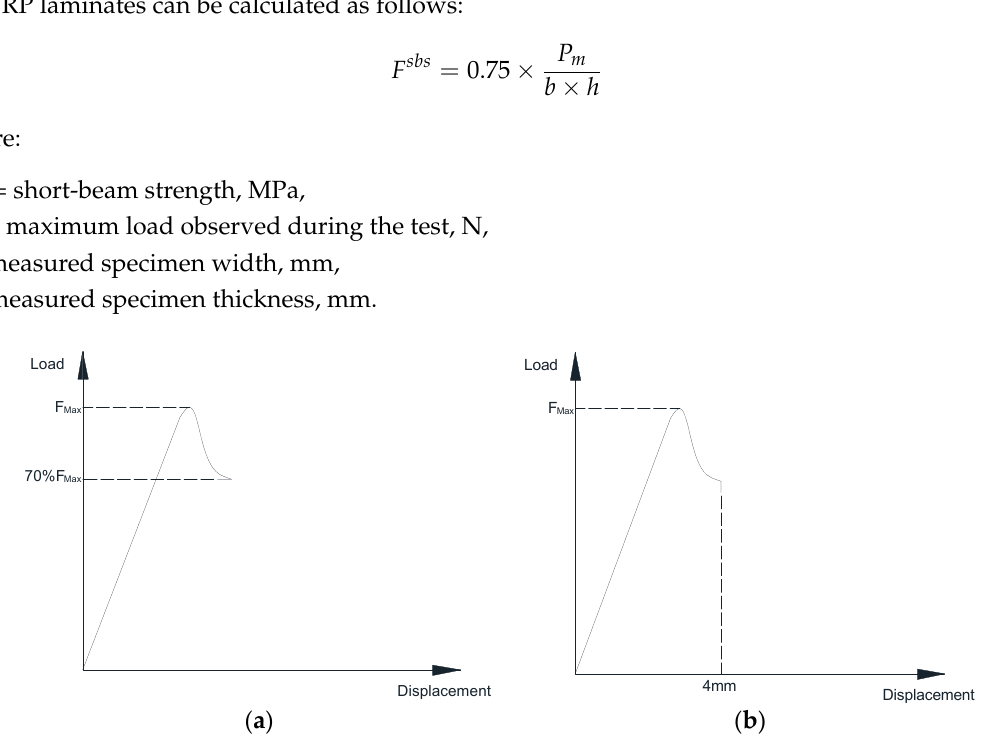
Figure 4. Termination rule for the short-beam shear test. ( a ) Drop to 30% of the maximum load; ( b ) Maximum displacement of 4 mm.